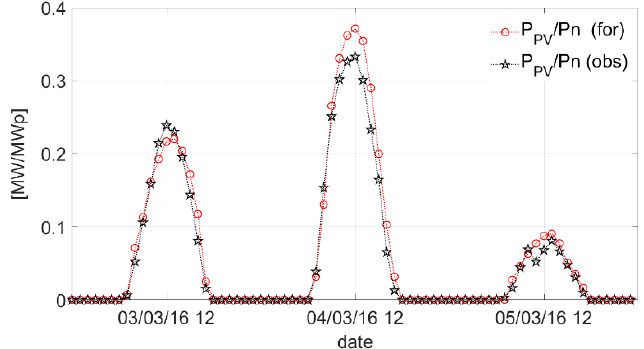
Figure 8. Observed and predicted PV generation profiles of three consecutive days (north